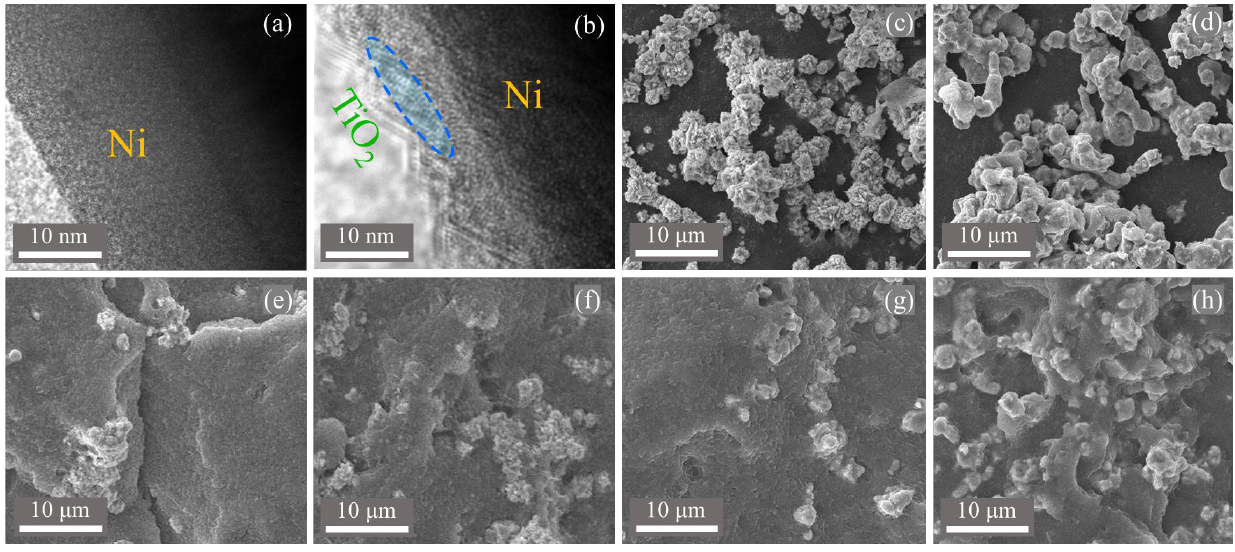
Figure 3. TEM and SEM pictures of ( a , c ) pristine Ni particles, ( b , d ) Ni@TiO 2 , ( e ) 30 wt% Ni – 0/PVDF, ( f ) 50 wt% Ni – 0/PVDF, ( g ) 30 wt% Ni – 4/PVDF, ( h ) 50 wt% Ni – 4/PVDF. ( f ) 50 wt% Ni–0/PVDF, ( g ) 30 wt% Ni–4/PVDF, ( h ) 50 wt%